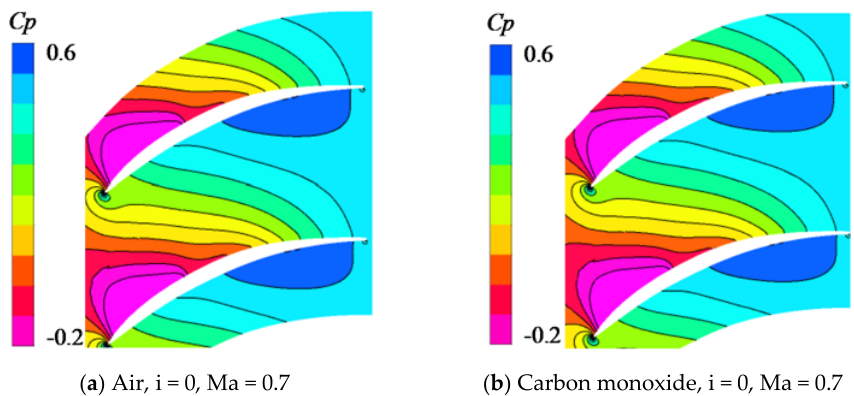
Figure 6. Static pressure coefficient (Cp) distribution at 98% span.